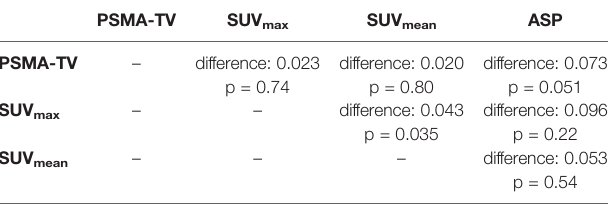
TABLE 4 | Comparison of AUC characteristics to detect high-risk prostate cancer using the DeLong test. PSMA-TV SUV max SUV mean